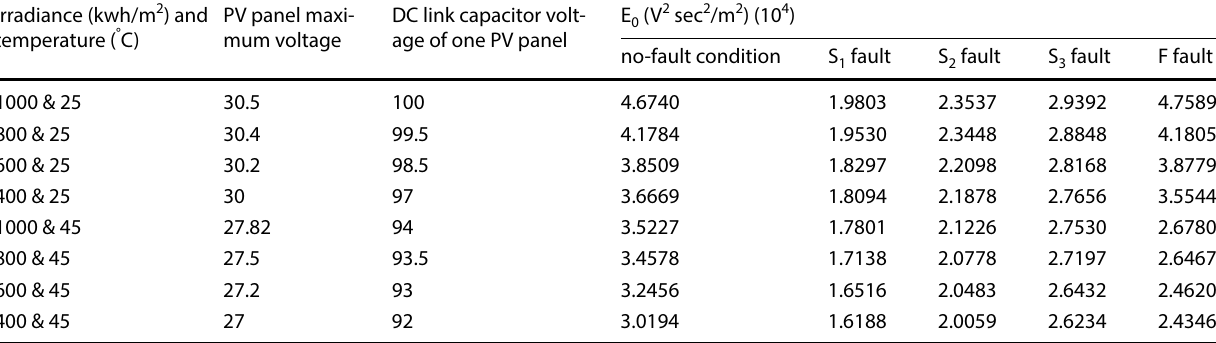
Fig.11 Multi resolution analysis for output voltage with no fault condition at 1000 w/m 2 and 25 °C Table 3 Energy levels for various open circuit fault Irradiance (kwh/m 2 ) and